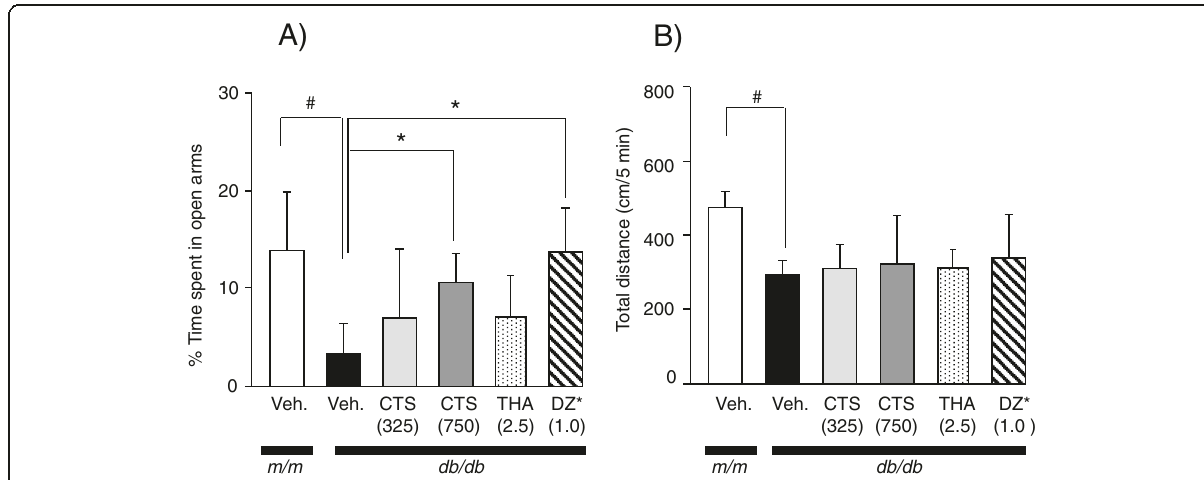
Figure 5 Effects of CTS administration on EPM performance of db/db mice. The animals received an EPM test at around the age of 13 weeks old. The 7-week-old db/db mice were orally administered water (vehicle), 375 – 750 mg/kg CTS, 2.5 mg/kg THA once daily during the experimental period. The EMT was conducted 1 hr after CTS administration. The age-matched naïve db/db mice received i.p. injection of 1 mg/kg diazepam 30 min before the test. Each datum represents the mean ± S.D. (6 – 9 animals per group). The proportion of time spent in open arms ( A ) and the total locomotion distance on the maze ( B ) were calculated. The data are expressed as the mean ± S.D. ### P < 0.001 vs. vehicle- treated m/m group (Student ’ s t -test). * P < 0.05, ** P < 0.01 vs. vehicle-treated db/db group (one-way ANOVA followed by Tukey